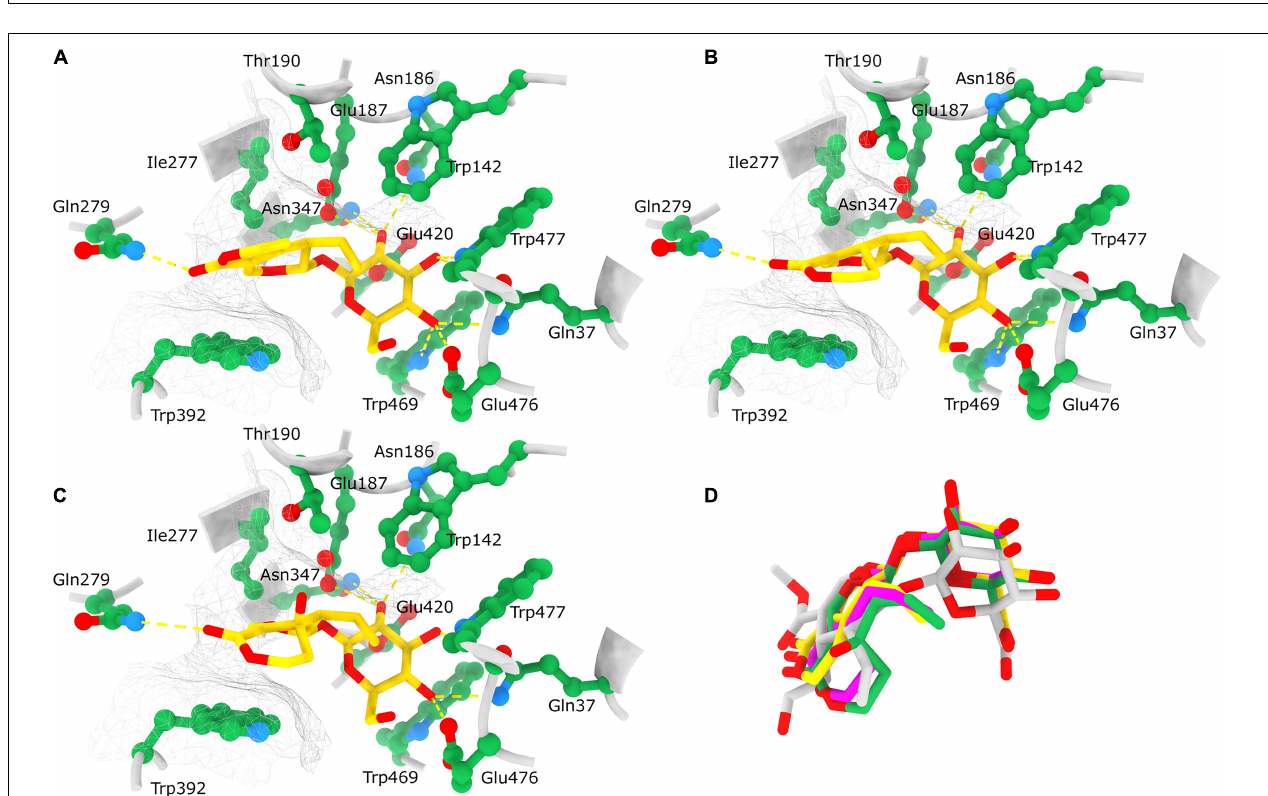
FIGURE 9 | Retaining double displacement reaction mechanism of GH1 β -glucosidase enzymes. Glu187 is the catalytic proton donor which activates the leaving group while Glu420 residue is the nucleophile. The reaction proceeds via a covalent glycosyl enzyme intermediate with an inverted bond which is hydrolyzed by nucleophilic attack of a water molecule, activated by the proton donor residue, resulting in second bond inversion and in overall anomeric retention.